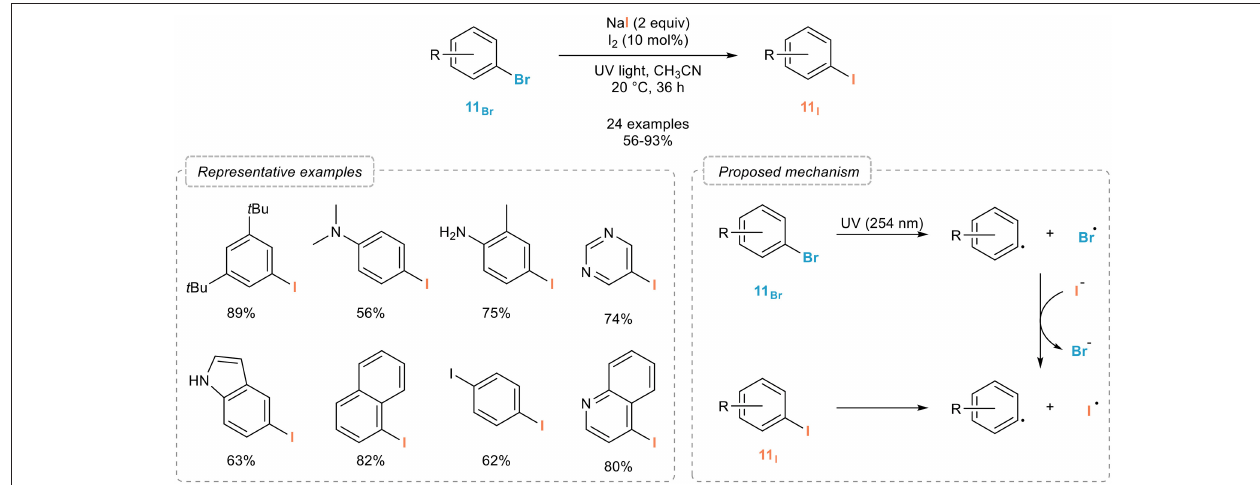
FIGURE 7 | Photo-induced aromatic Finkelstein